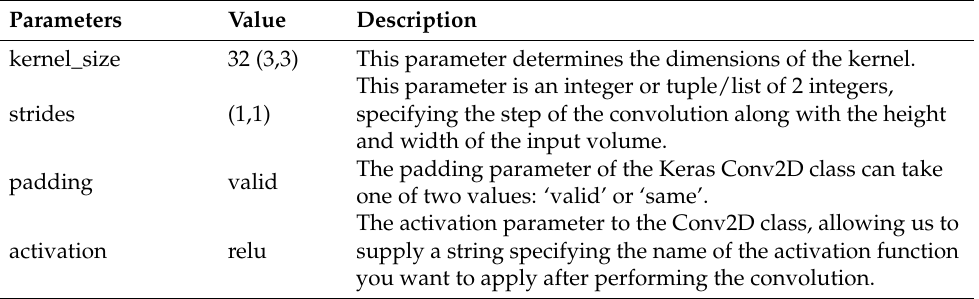
Table 15. CNN parameters from TensorFlow tf.keras.layers.Conv2D